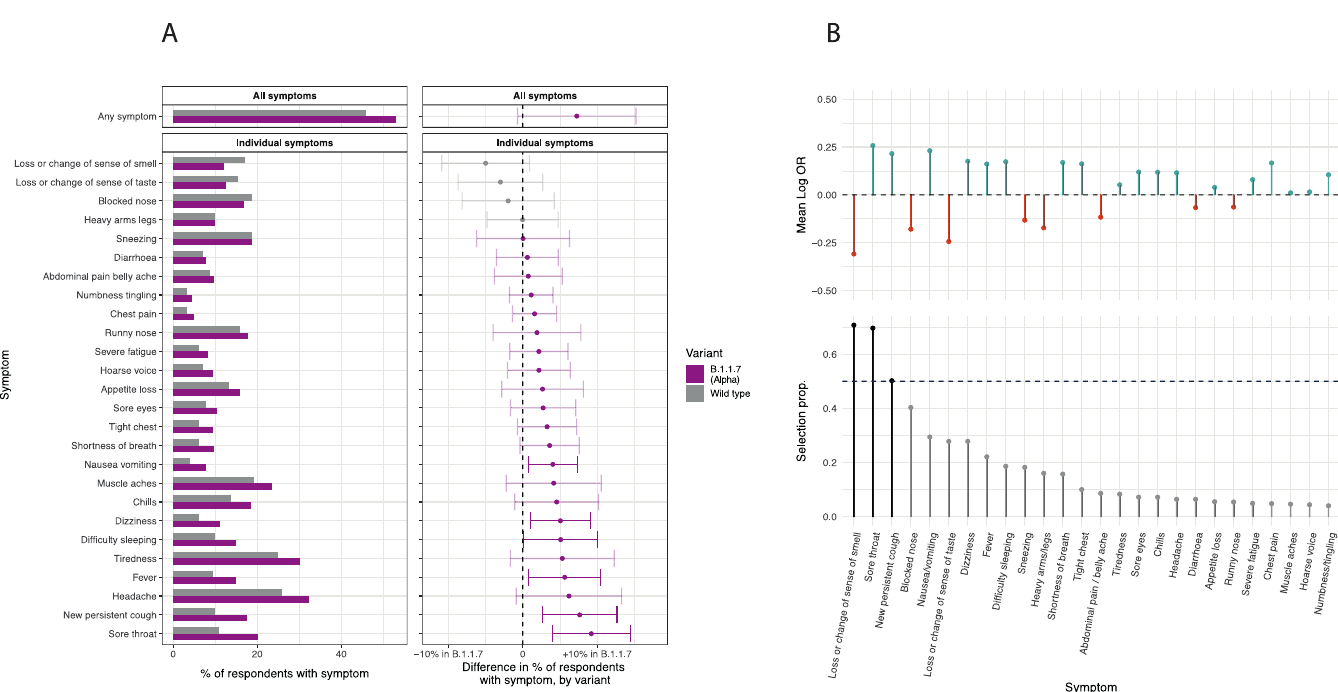
Fig 5. B.1.1.7 versus wild-type symptoms. Comparison of symptom profile in B.1.1.7 (Alpha) lineage versus wild-type infection among 1,124 people testing positive in round 8 (other lineages excluded, N = 8). (A) Proportion of people reporting each symptom by lineage (left panel), and the differences in proportions with 95% confidence intervals (right panel). (B) Results of LASSO stability selection (using 1,000 models with 50% subsampling) with B.1.1.7 infection, versus wild-type infection as the outcome, summarized by the mean log odds ratio (Log OR) and selection proportion (selection prop.) for each of the symptoms selected at least once. Positive regression coefficients are presented in teal, and negative in red. The horizontal dashed line represents the selection threshold of 50%.